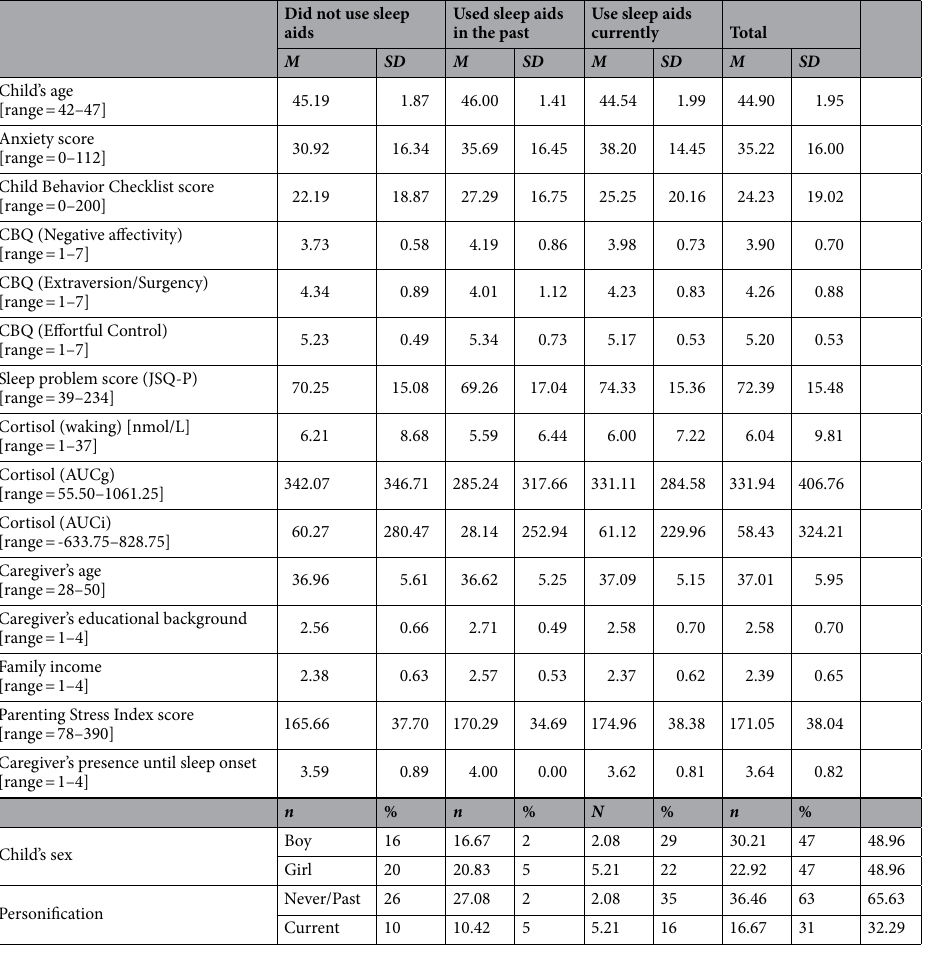
Table 1. Descriptive statistics for all variables according to sleep aid use: means followed by standard deviations. One girl’s and one boy’s caregiver did not report sleep aid use and hence, the total number of participants was 94 for the child’s sex and personification. Means and standard deviations were estimated using multiple imputations. The following variables were used as dummy codes: caregiver’s educational background (1 = high school, 2 = junior college, 3 = 4-year-college/university or graduate school), family income (1 = less than ¥3,000,000, 2 = ¥3,000,001—¥7,999,999, 3 = ¥8,000,000–¥19,999,999, 4 = more than ¥20,000,000), and caregiver’s presence (1 = never, 2 = 1–2 days/week, 3 = 3–5 days/week, 4 = almost daily). CBQ = Child Behavior Questionnaire. Range indicates possible score ranges for questionnaires and observed score ranges for the other variables. CBCL and sleep problem scores (JSQ-P) had cutoff points. Nine percent of children were in the clinical range of the CBCL, and 25% were in the clinical range of the JSQ-P, which were consistent